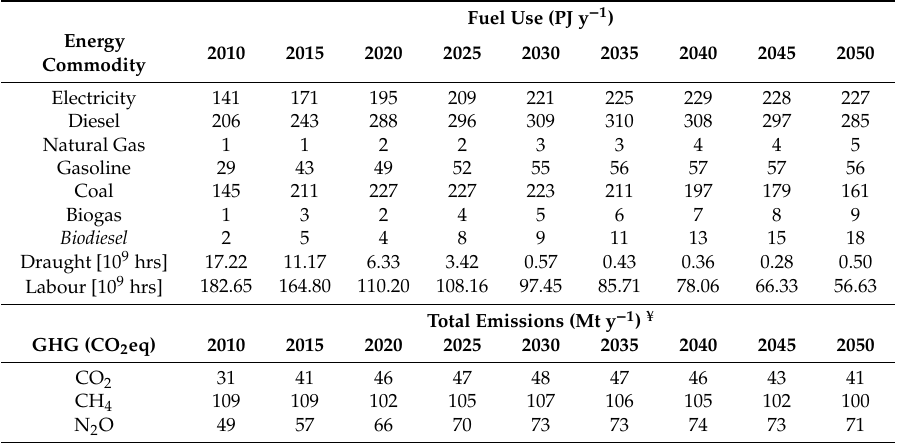
Table 12. Farm-related energy use and emissions in the reference